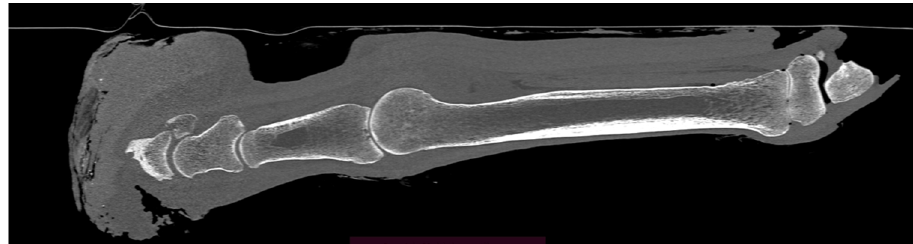
Figure 13. Sagittal CT image (bone algorithm, WW1500, WL300) from postmortem examination, presenting significant deformation and atrophy of the coffin bone, as well as distortion of the hoof capsule with a loss of continuity. Additionally, osseous ‐ cyst like lesion is visible in the long pastern bone.